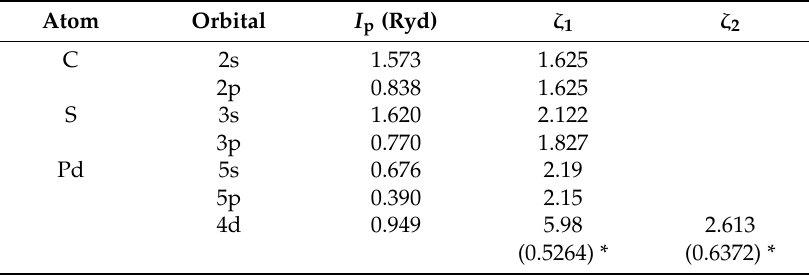
Table 1. Semi-empirical parameters for Slater-type atomic orbitals. Atom